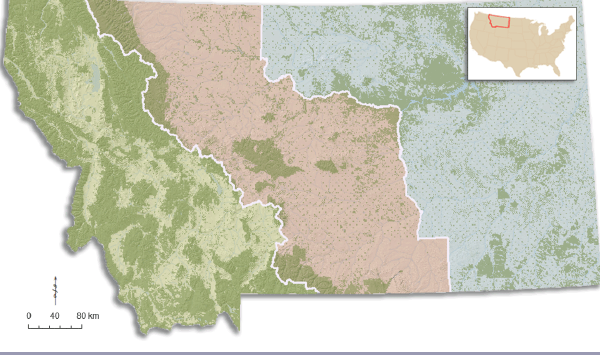
Fig. 1 . Map of Montana with the three regions, Western, Central and Eastern, used in survey implementation. Areas shown in green are public